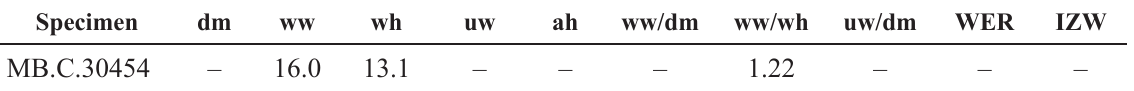
Table 3. Conch dimensions (in mm) and ratios of Stroborineceras felis gen. et sp. nov. Specimen